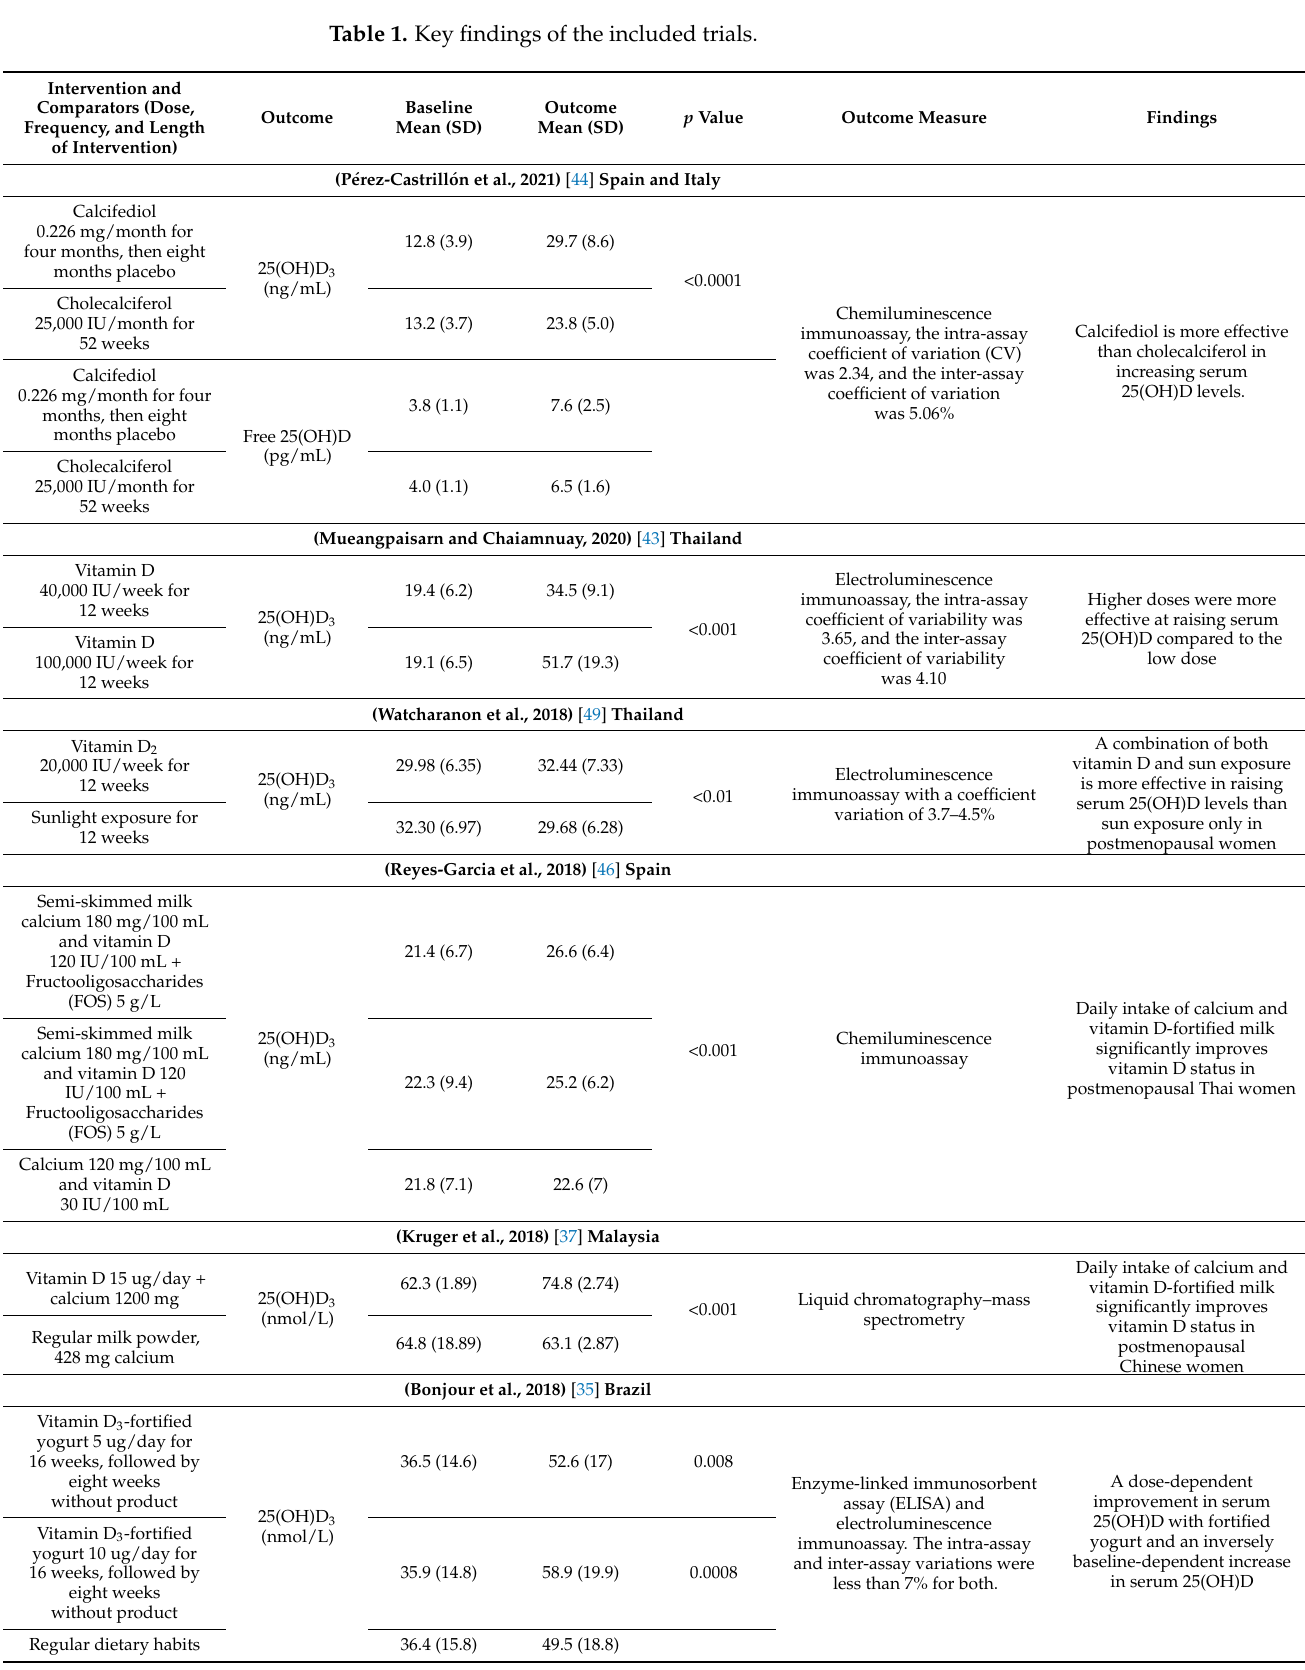
Table 1. Key findings of the included